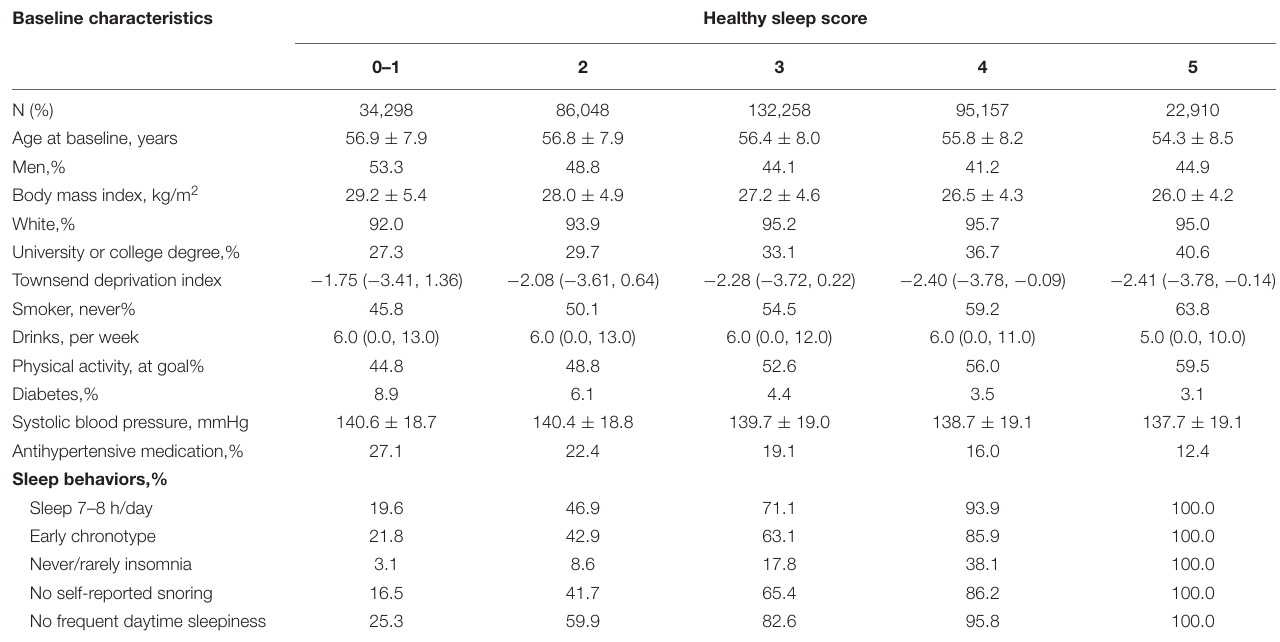
TABLE 1 | Baseline characteristics of 370,671 participants according to healthy sleep